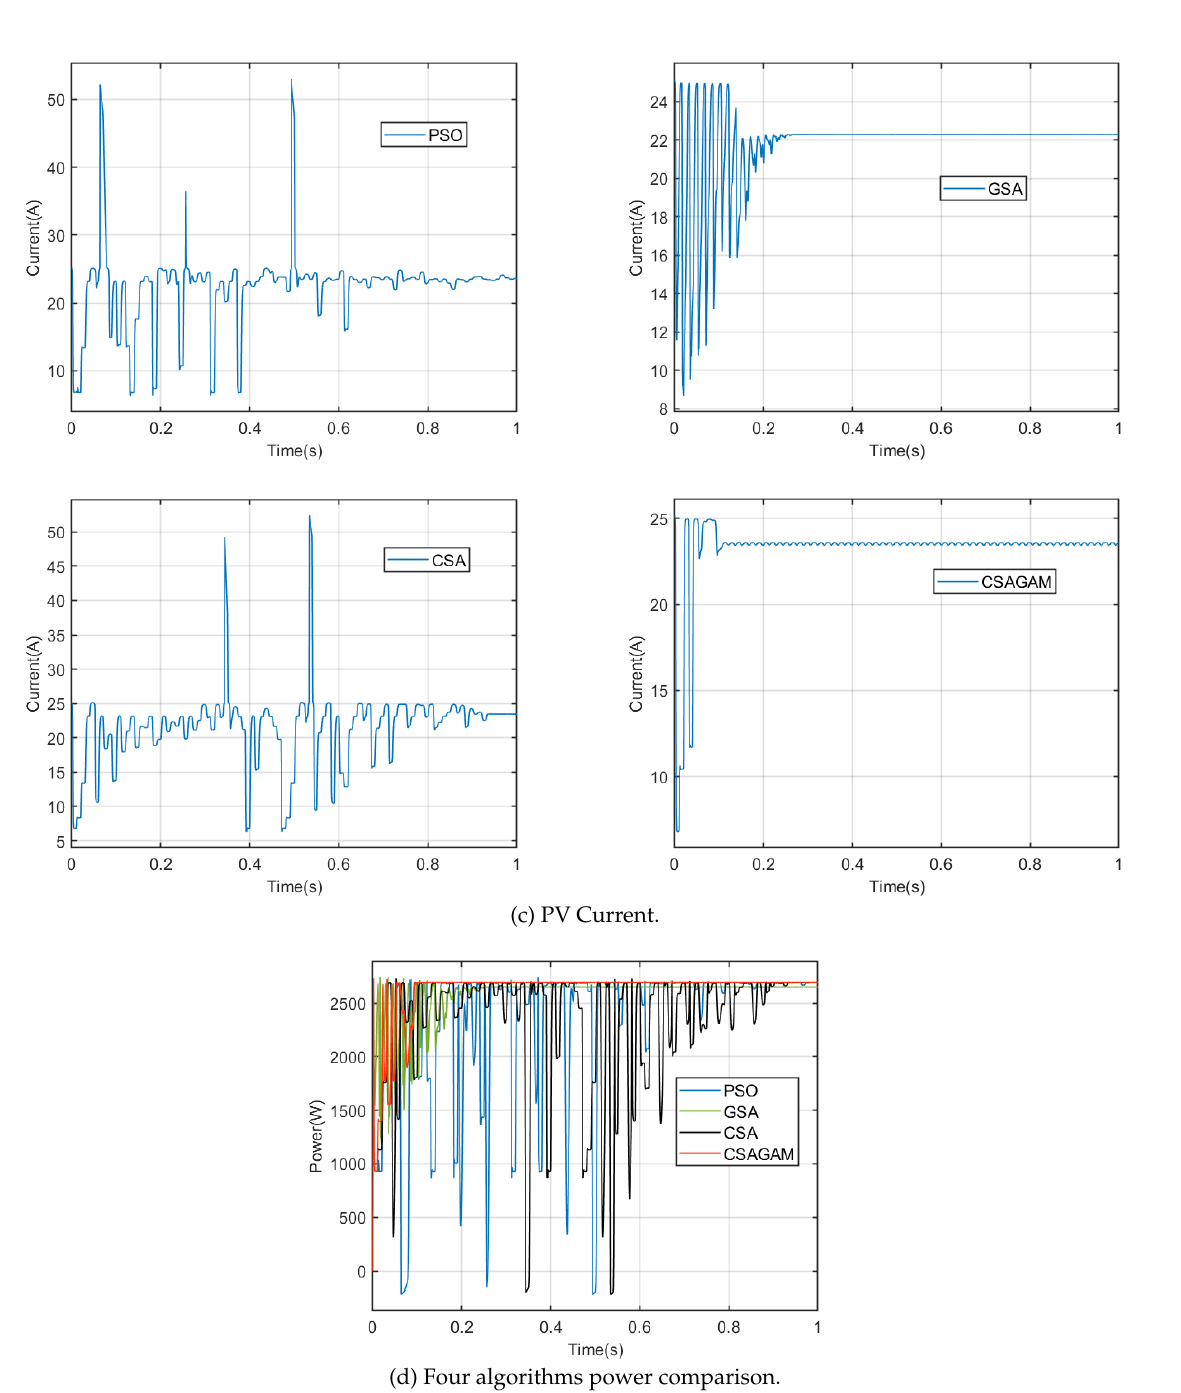
Fig. 8. Simulation results for the first partial shading case PSC 3.